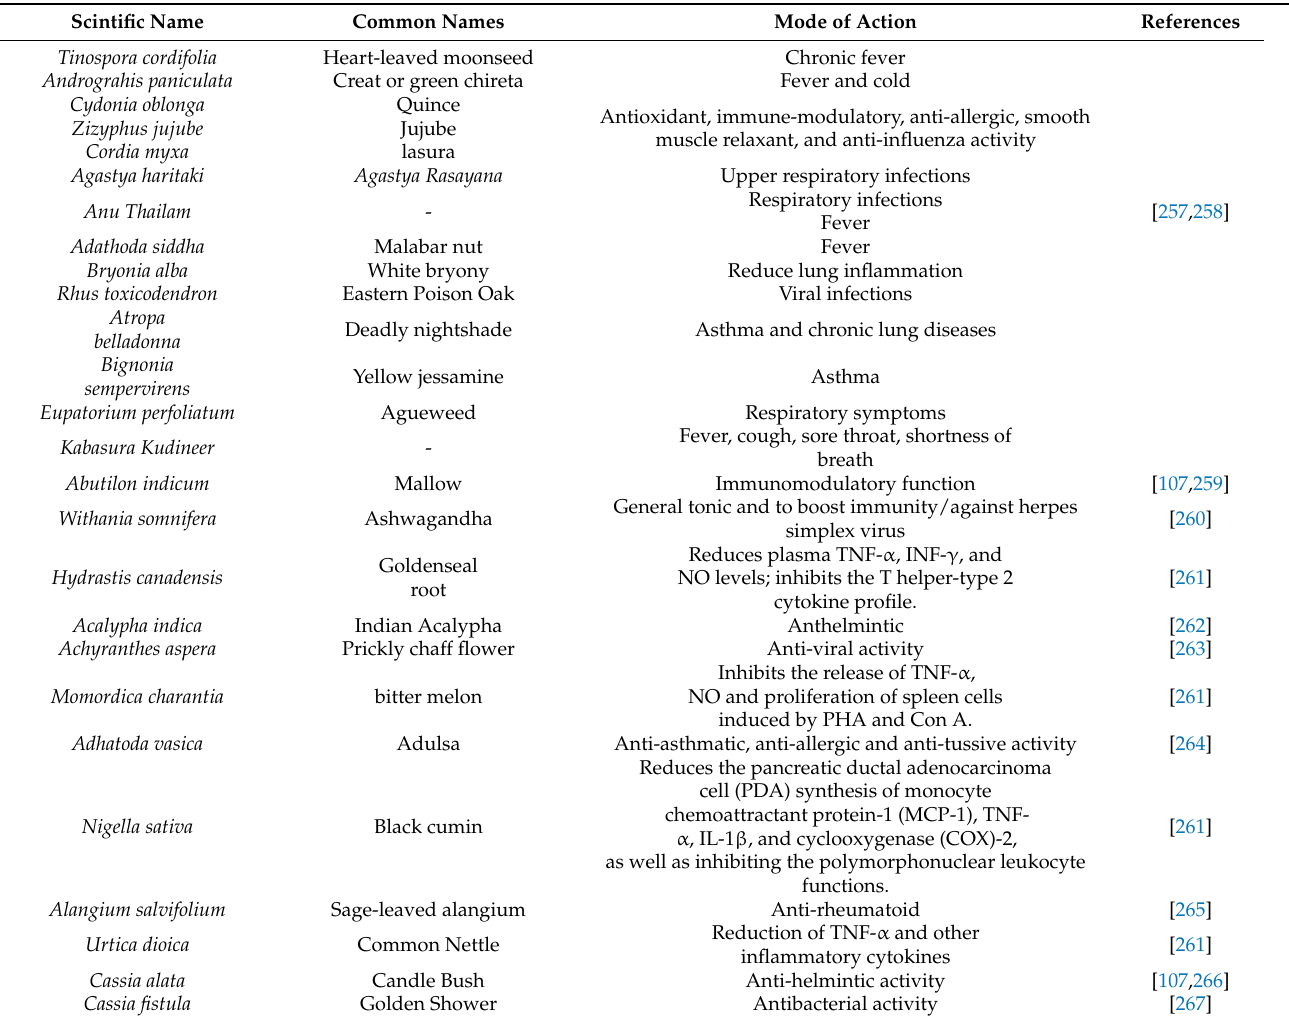
Table 4. List of commonly used medicinal herbs involved in treatment of respiratory